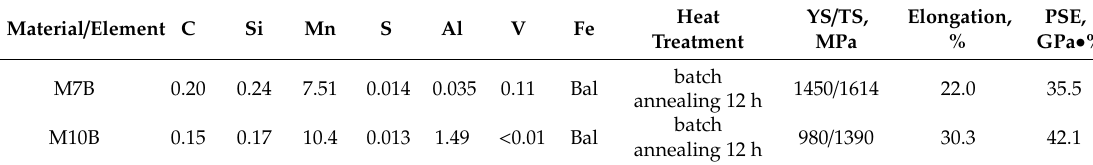
Table 1. Chemical composition in wt. % and mechanical properties of medium Mn steel (MMS). Material / Element